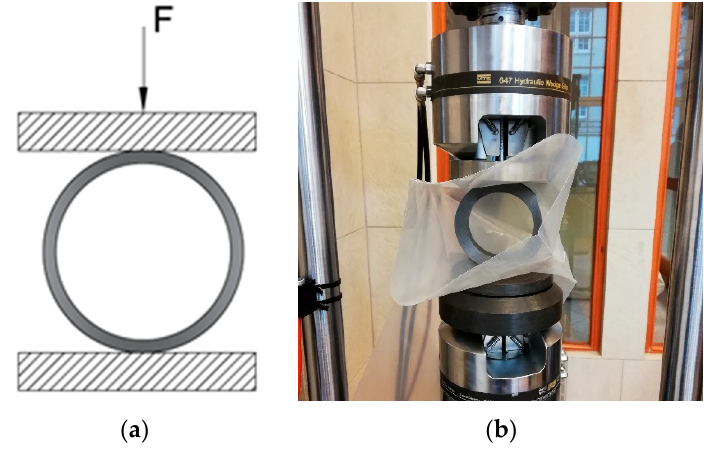
Figure 5. Radial compression of composite rings: ( a ) scheme of the experimental boundary conditions and ( b ) view of the sample mounted on the machine.